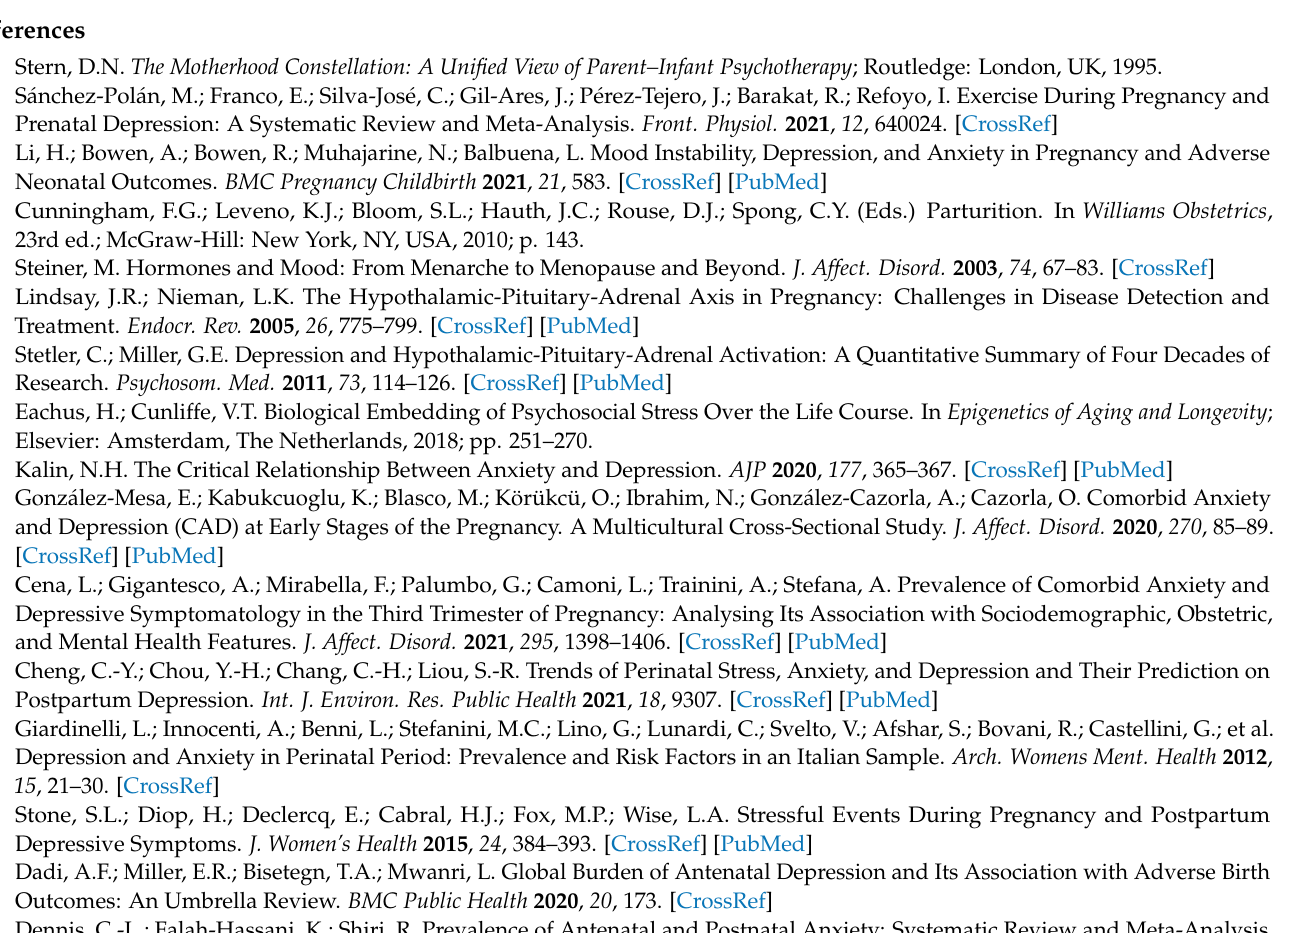
as percentages. Table S1: PRISMA 2020 checklist. Table S2: Excluded studies with reasons. Table S3: Study sample characteristics. Table S4: Outcome characteristics. Table S5: Sub-group analysis using a fixed-effect